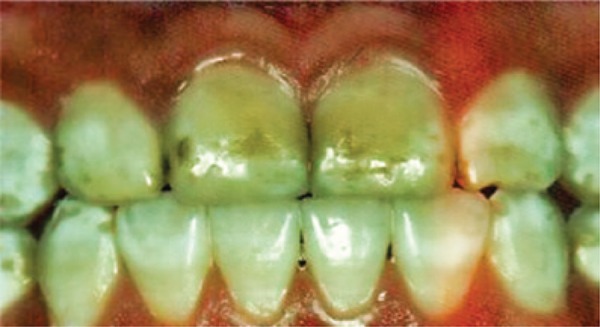
Dentes com fluorose severa